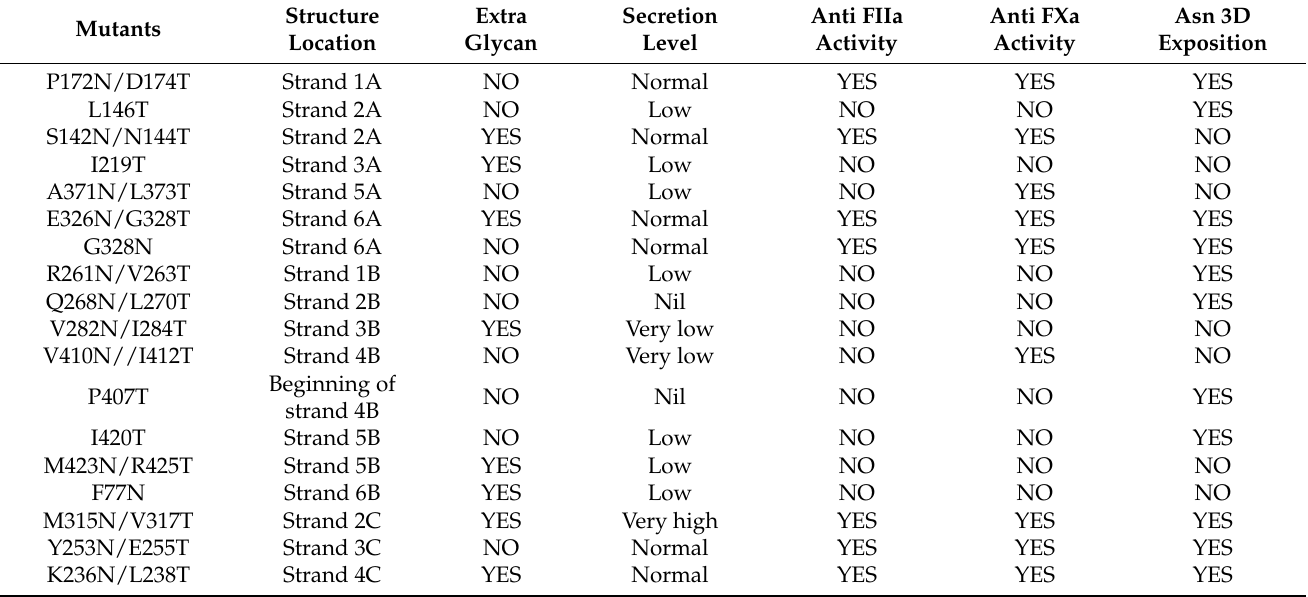
Table 1. Mutations generating new N-glycosylation sites in antithrombin and the resulting effects. The consensus sequence was not introduced within strand 1C because it would have completely eliminated the strand. In the case of strand 4A, we did not introduce a consensus sequence as it folded as a strand only in the latent conformation. Each mutant only had one extra glycan. The numbering of residues refers to the mature sequence of